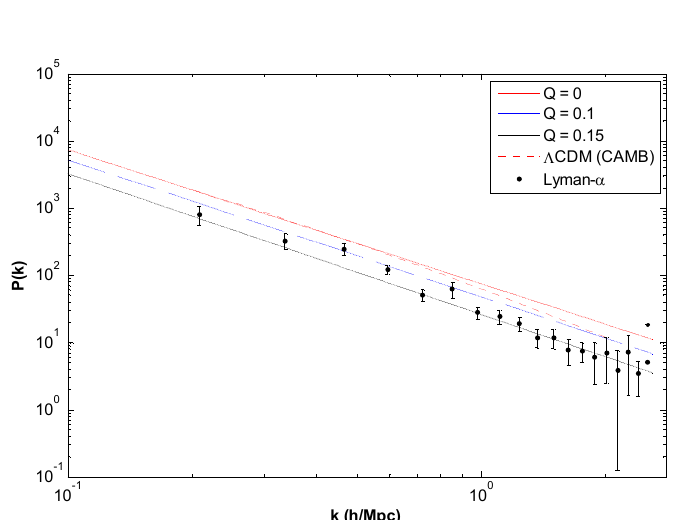
Figure 2 . Matter power spectrum on small scales for 𝑛 (cid:3046) (cid:3404) 0 with various 𝑄 compared to Λ CDM model from CAMB and Lyman (cid:3398)𝛼 data from